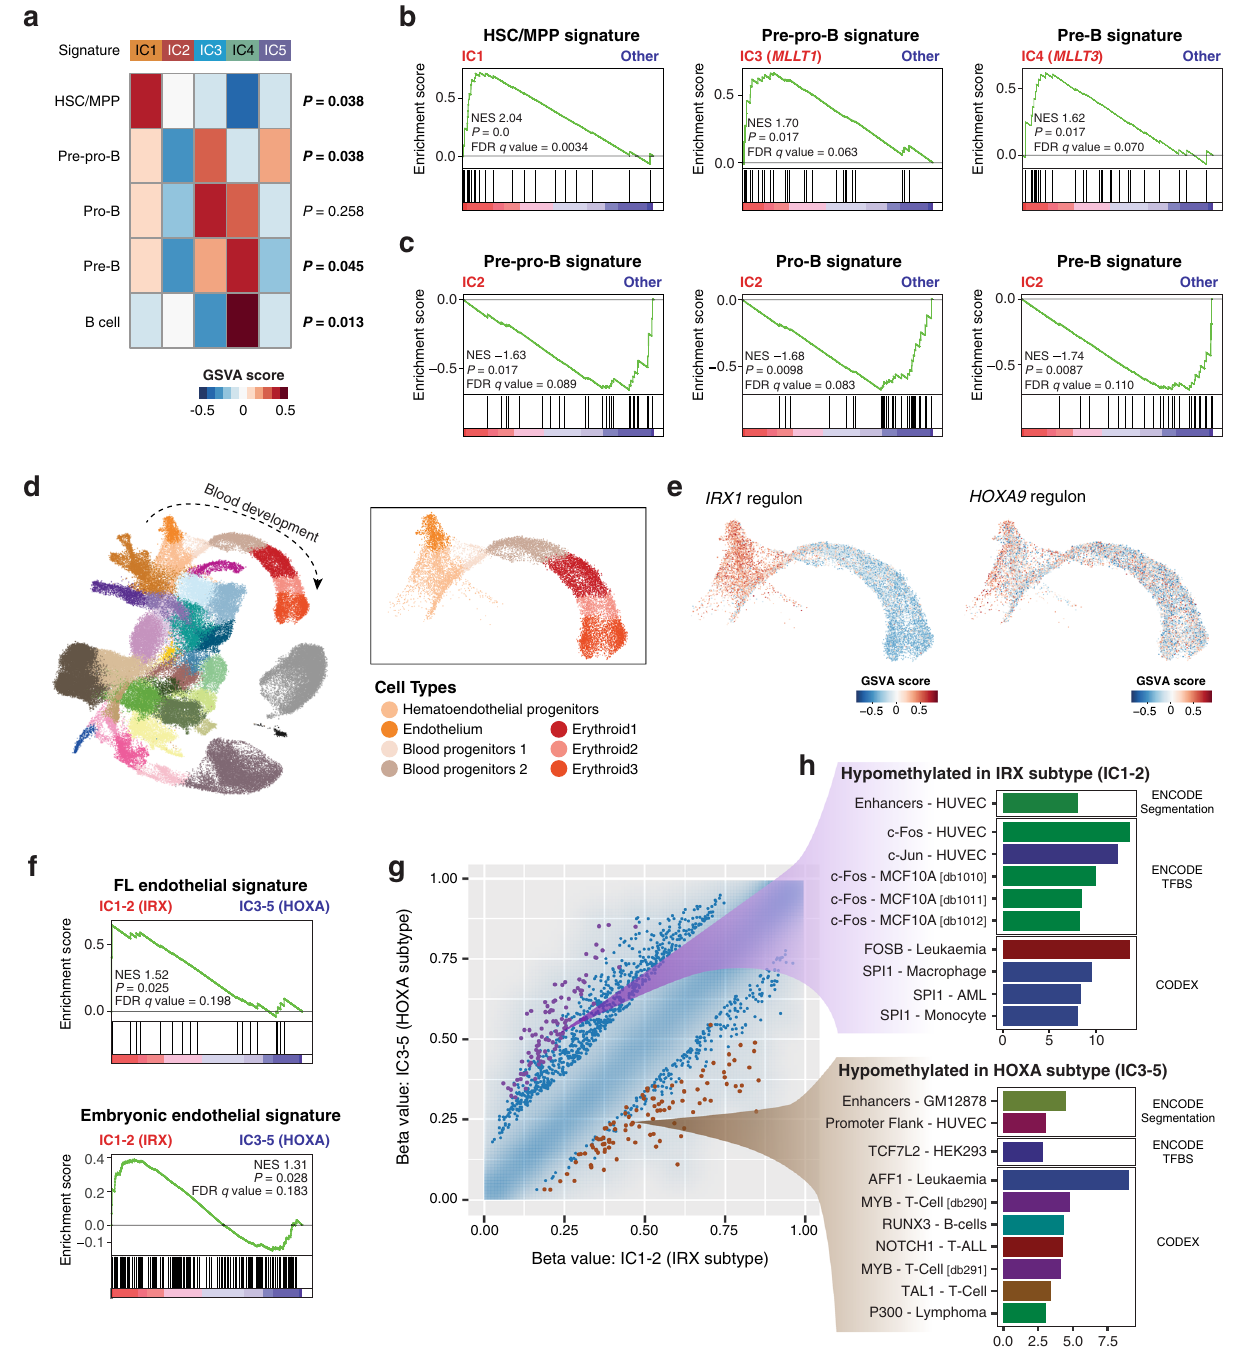
Fig. 3 | Differential enrichment of B-lineage and hemato-endothelial develop- mental signatures in KMT2A -r infant ALL. a Enrichment analysis comparing the expression of B-cell developmental signatures in the fi ve ICs. Enrichment scores werecalculatedattheindividualsamplelevelusingGSVA,andthemedianvaluefor each signature in each cluster is plotted. Kruskal – Wallis P values are indicated on the right of the heatmap. b Cluster-speci fi c enrichment of B-lineage signatures evaluated with GSEA. NES normalized enrichment score, FDR false discovery rate. c Signi fi cant under-enrichment of B-progenitor signatures in IC2. d Uniform manifoldapproximationandprojection(UMAP)visualizationofapublishedsingle- cell gene expression atlas of murine gastrulation ( n =116,312 cells) 26 . The right upper box shows a magni fi ed section of the blood development trajectory